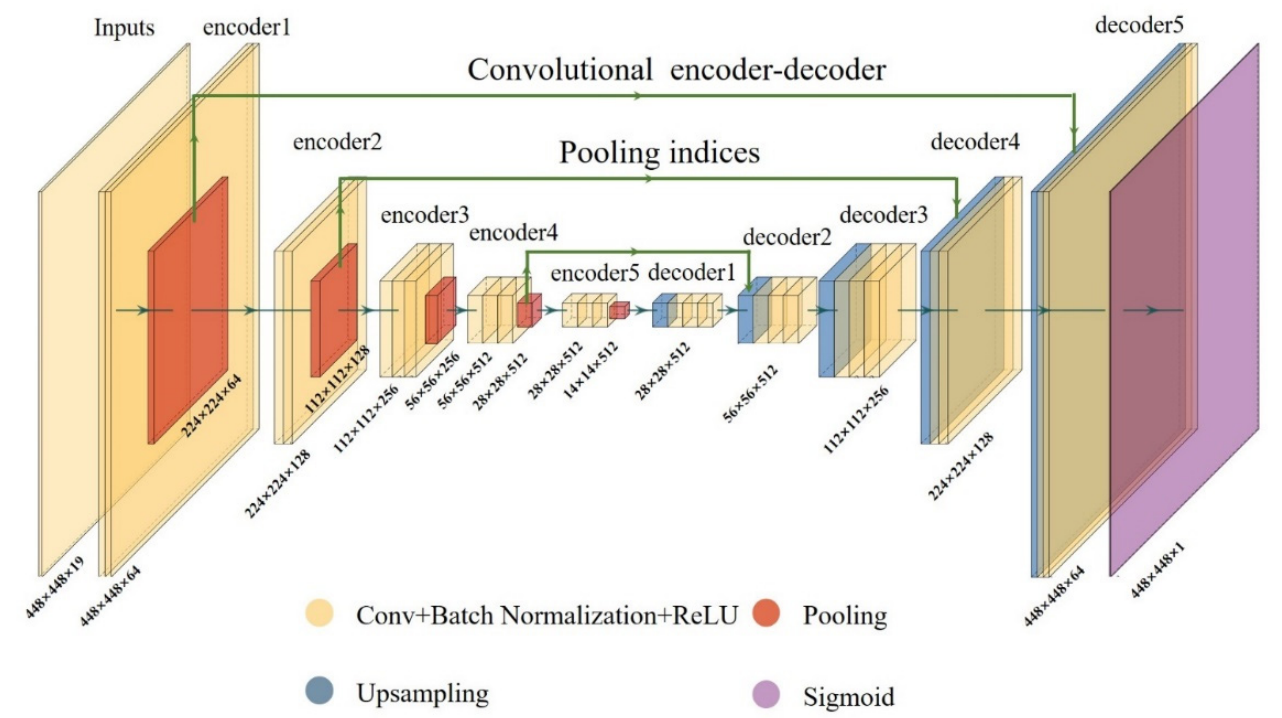
Figure 3. Network structure of the Lightning-SN model.